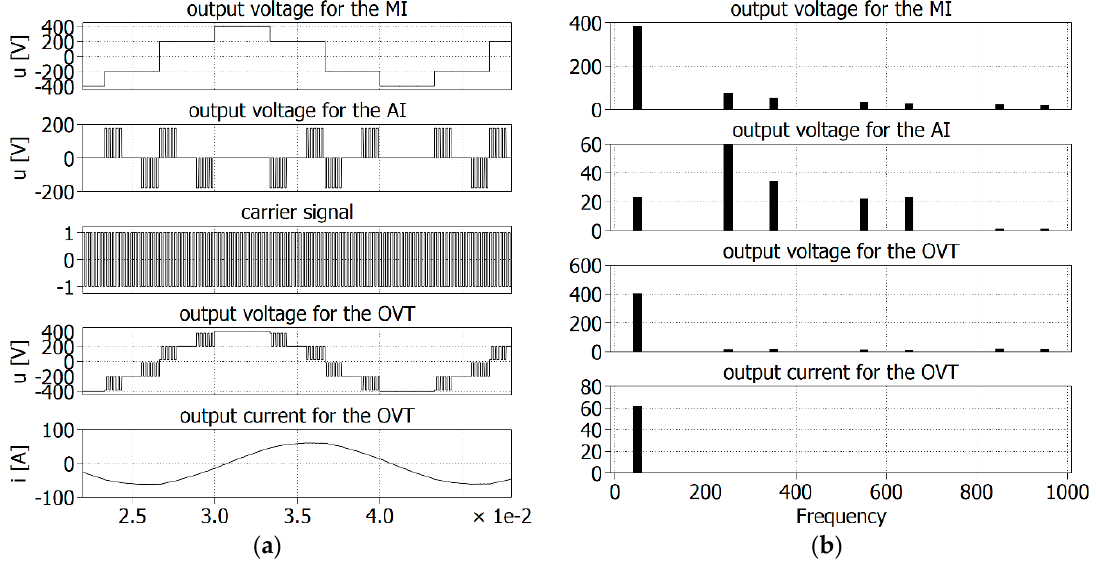
Figure 13. The voltage and current waveforms ( a ) for the OVT inverter under resistive loads and their spectra ( b ) with the use of a pulse generator.